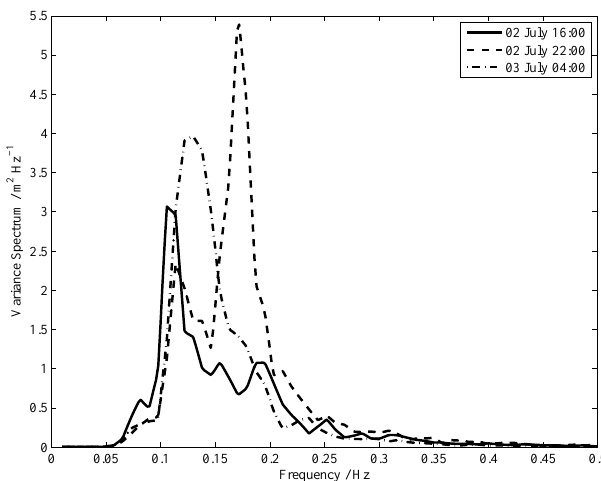
Fig. 5. Time evolution of wave spectra over six-hour time